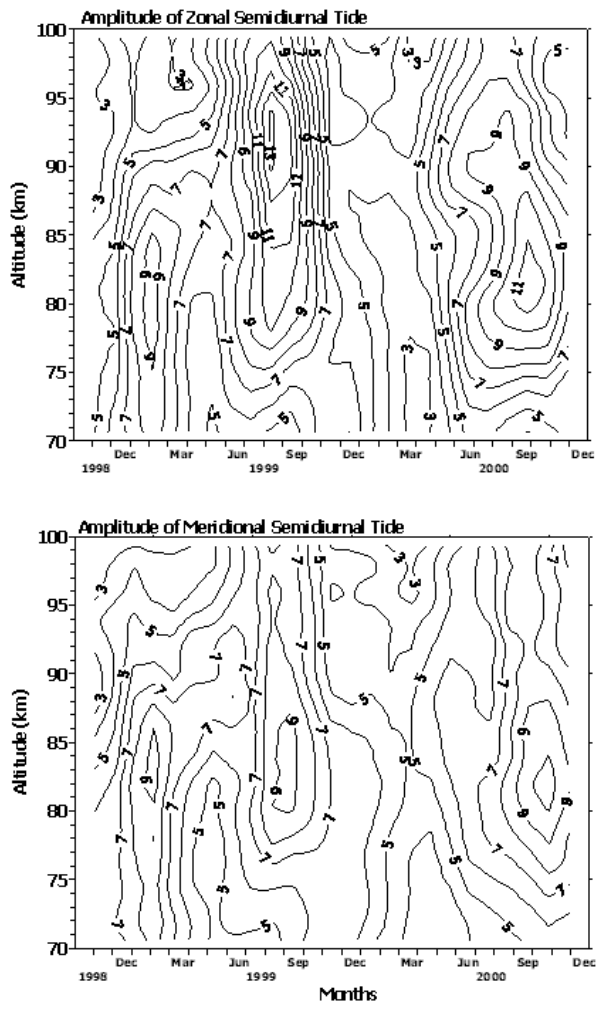
Fig. 8. Height-time cross section of amplitude of the semidiurnal tide of October 1998–December 2000.